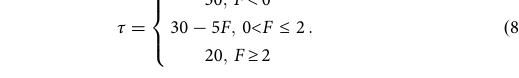
The form of τ is plotted in Supplementary Fig. 4b. The resultant weighting of L f in the fading model using the end-members of τ is displayed in Supplementary Fig.